Question: Write a single sentence explaining what this figure depicts.
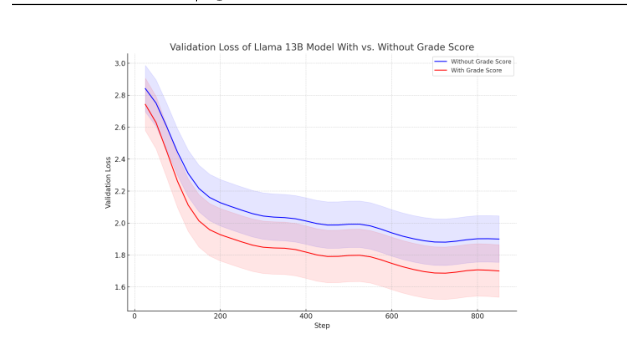
Answer: The plot shows the validation loss of the Llama 13B model over a subset of the training steps, comparing the performance with and without the application of a grade score supplied by the regression model. This plot highlights the impact of the grade score leading to better generalization and lower validation loss over time.